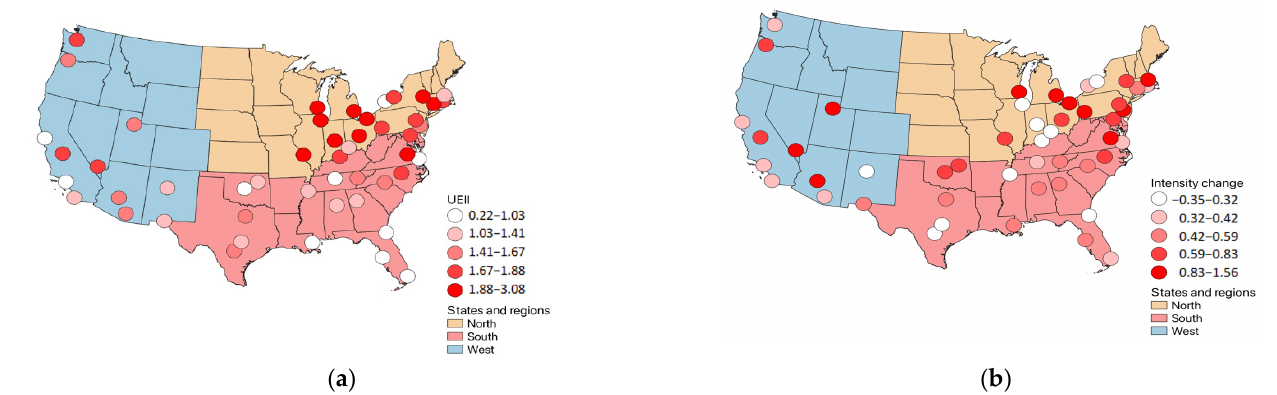
Figure 4. The relationship between UEII and intensity change values; ( a ) spatial pattern of UEII values; ( b ) spatial pattern of intensity change values.